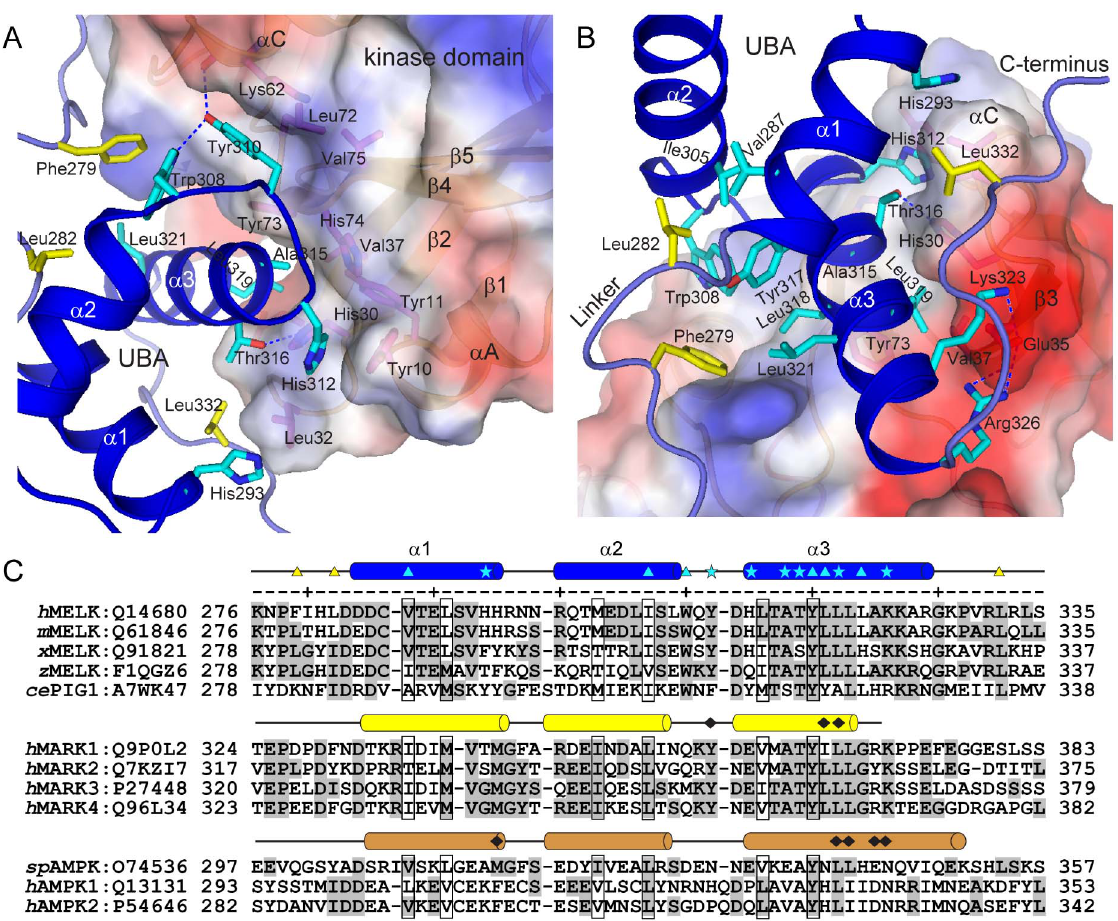
Figure 3. Tight interactions between the kinase domain and the UBA domain. (A and B) Hydrophobic and hydrophilic interactions at the KD-UBA interface. The kinase domain is shown in surface representation and is colored according to the electrostatic potential (positive, blue; negative, red). The residues from the UBA domain are highlighted as cyan sticks, and the residues from two linkers flanking the UBA domain and from the kinase domain are highlighted as yellow and magenta sticks, respectively. Hydrogen bonds are indicated by blue dashed lines. (C) Sequence alignment of MELK-UBAs, MARK-UBAs and AMPK-AIDs. The code following each protein name is the corresponding Swiss-Prot ID. The residues of MELK-UBA involved in the interaction with the kinase domain are indicated by cyan asterisks, and the interacting residues of MARK-UBA and AMPK- AID are indicated by black diamonds. The residues involved in the interactions between MELK-UBA and its flanking linkers are indicated by cyan and yellow triangles, respectively. h , human; m , mouse; x , Xenopus ; z , zebrafish; sp , S. pombe .